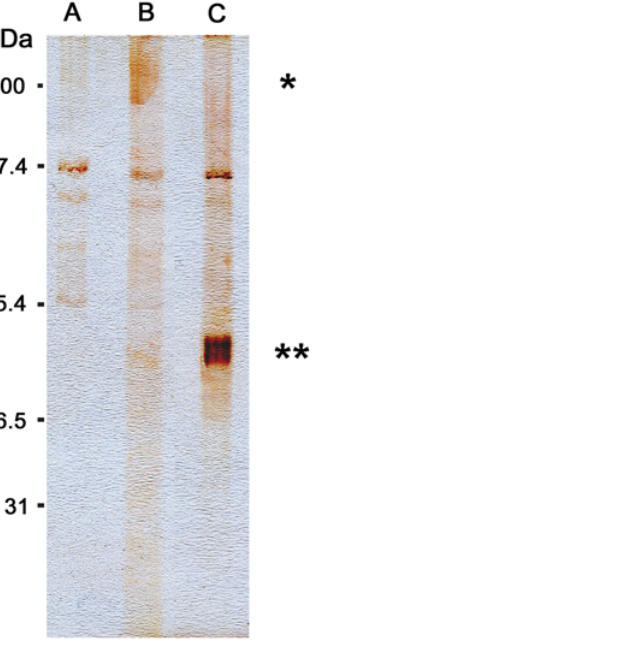
FIGURE 2 . Silver-stained 12.5% SDS-polyacrylamide gel of decorin samples purified by HPLC-DEAE . Lane A: enyzme control (chondroitinase ABC); lane B: undigested decorin, the position of the proteoglycan form of decorin is indicated by an asterisk (*); lane C: chondroitinase ABC–treated decorin, the position of the core protein of decorin is indicated by a double asterisk (**); left margin: migration positions of molecular weight markers (kDa).